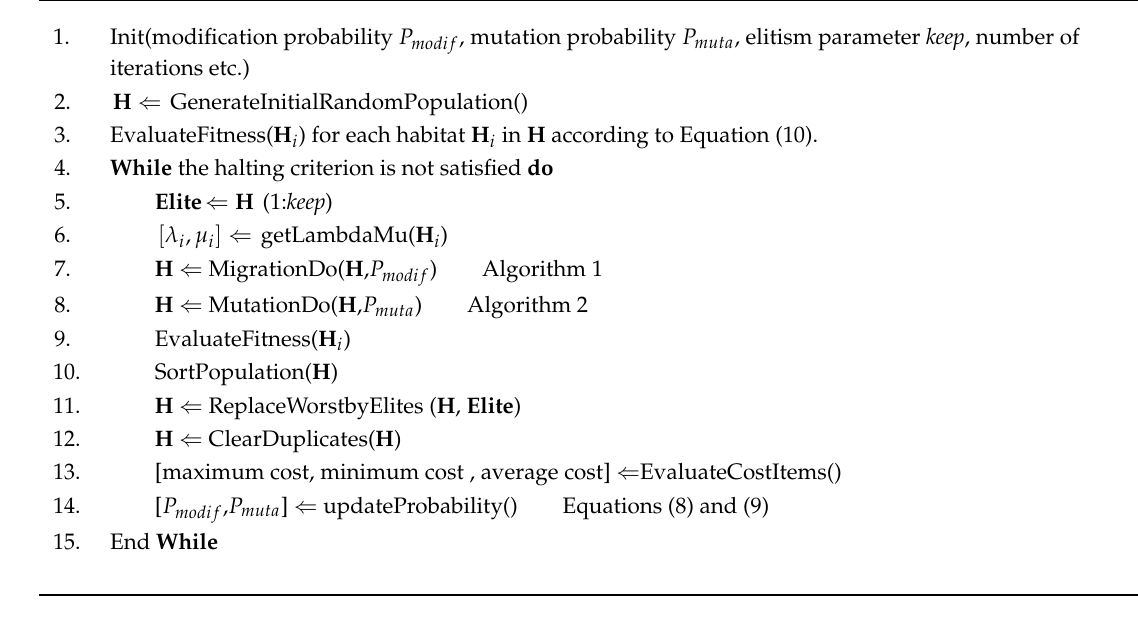
Algorithm 3 The main procedure of MABBO for